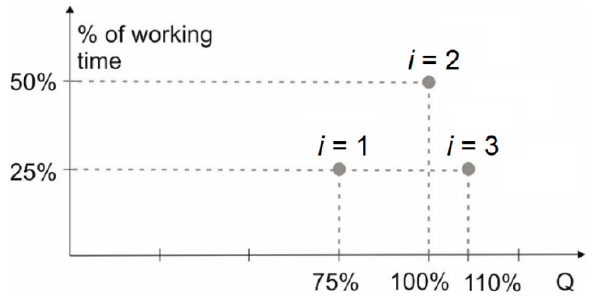
Figure 2. Flow versus time for the constant flow pump units [38,39].